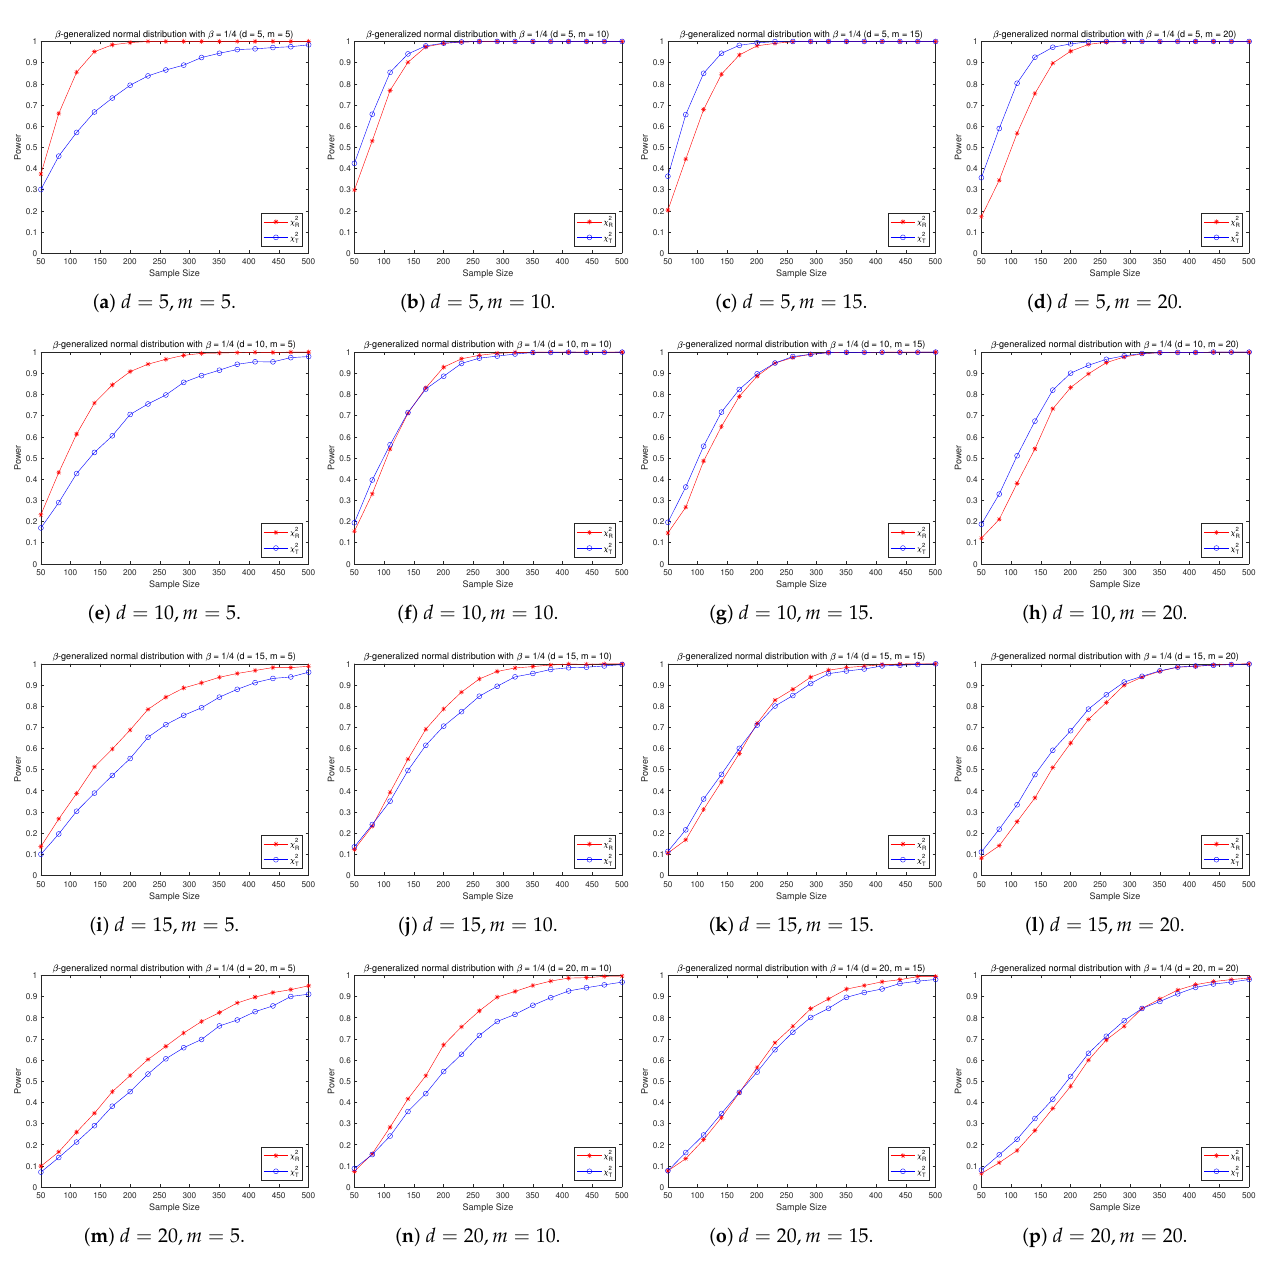
Figure 2. The β -generalized normal distribution with β = 1/4. Red line for RP-chi-square, blue line for traditional